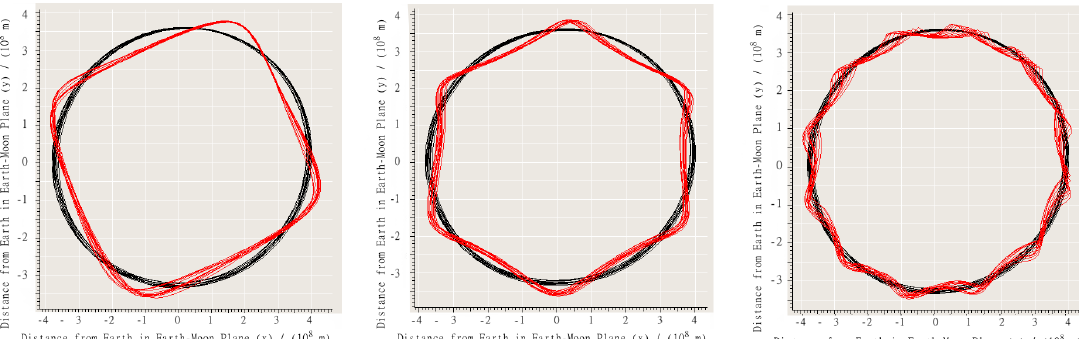
Figure 5. The 1:3:4 (left), 1:5:6 (center), and 1:11:12 (right) Resonances. In each plot, the black line (circular trajectory) represents the lunar orbit, and the red line (non-circular trajectory) the DRO. Both trajectories are shown relative to the inertial frame; the lines illustrate the respective trajectory on the Earth–Moon plane in the Earth-centered inertial